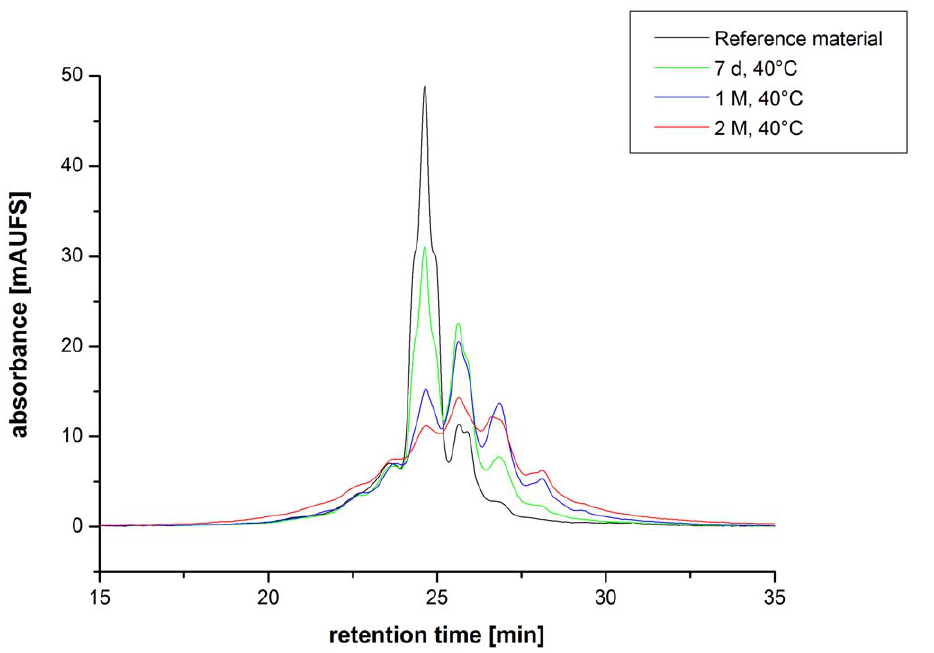
Figure 4. Cation-exchange chromatography of Mab1 reference material versus selected stressed samples (stored at 40 6 C; 7 days, 1 and 2 month).